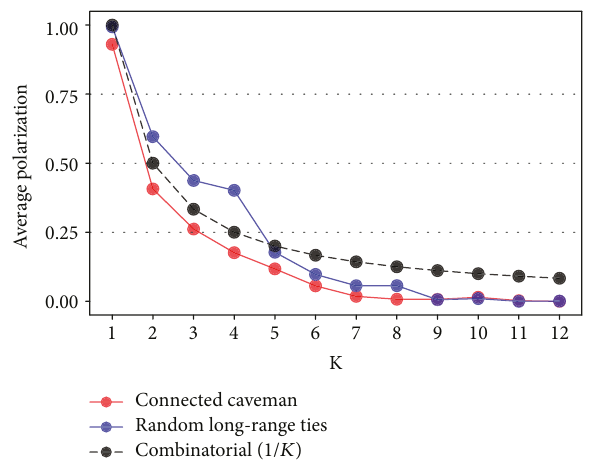
Figure 10: Polarization resulting from FM model simulations under connected caveman and random long-range tie conditions, compared with polarization resulting from agents arbitrarily choosing a corner of opinion space at random. Monte Carlo simulations revealed that polarization goes as 1/ K if agents simply pick a corner at random. Random long-range and connected caveman data points are averaged from 100 trials with 10 4 iterations. Combinatorial condition data points are the average over 1000 trials and 10 4 iterations. Standard deviation around combinatorial trial averages was less than 10 − 2